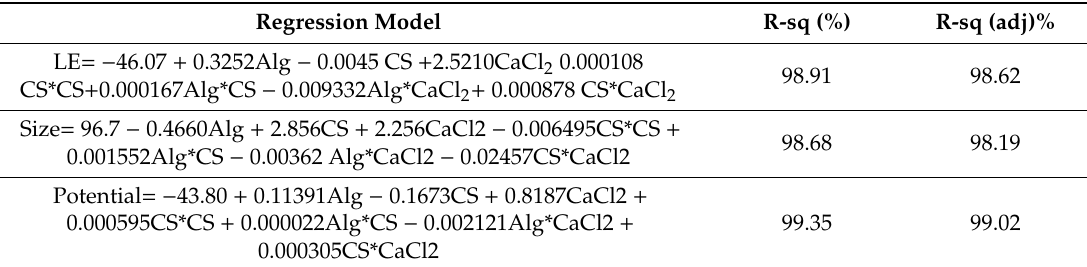
Table 4. Regression model for dependent variables.